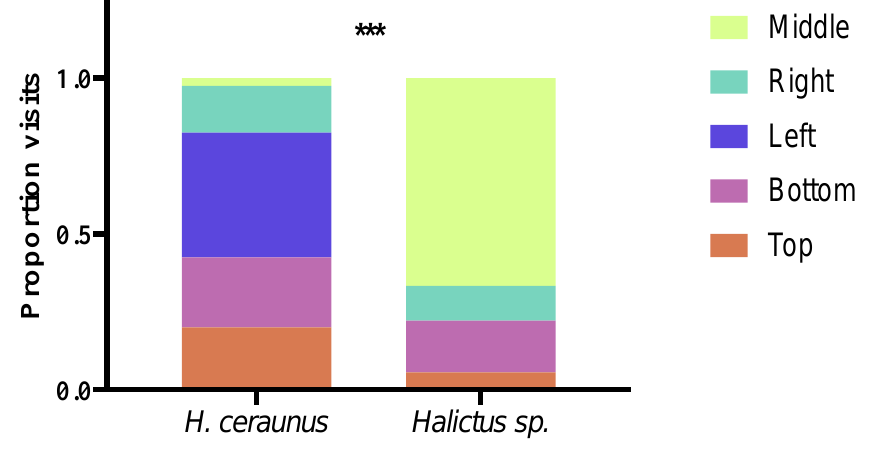
F IGURE 3. Floral landing patterns of the two most common Allionia visitor taxa, Hemiargus ceraunus and Halictus. Bars represent the total visits by each species, colors indicate the different possible landing positions and the proportion of landings to each position. Asterisks indicate a statistically significant difference (P < 0.001) between species in overall landing patterns based on Likelihood Ratio